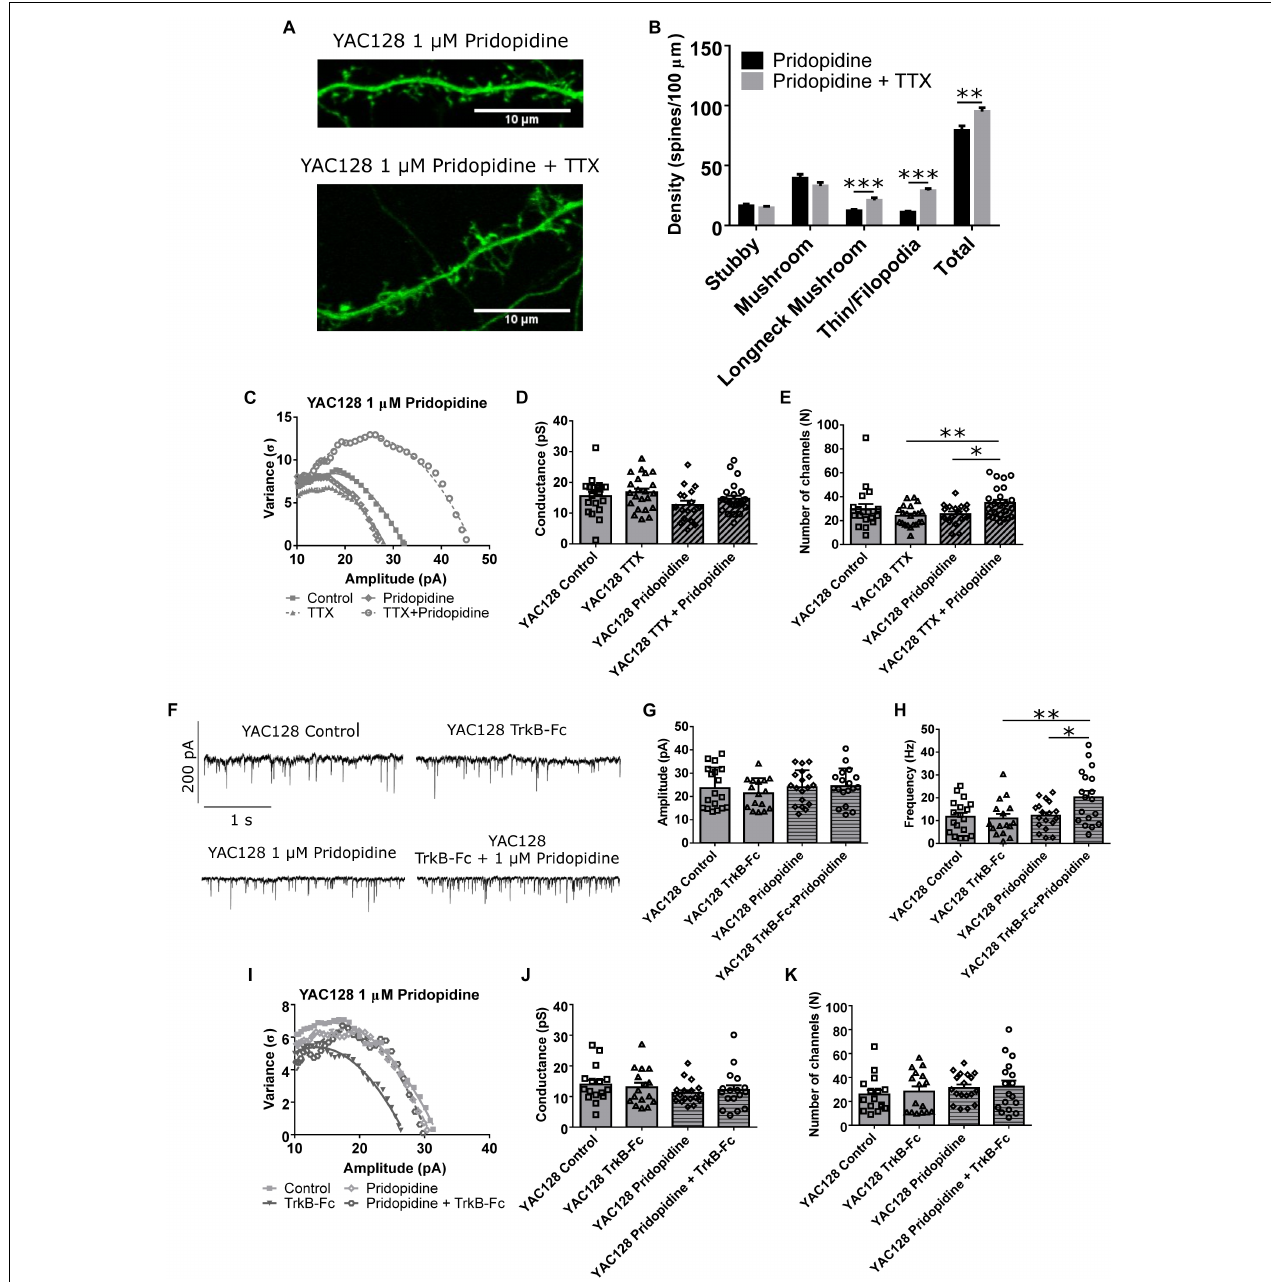
FIGURE 5 | Pridopidine restores other aspects of homeostatic plasticity. (A) Representative images of spines on CPNs filled with GFP. (B) Spine density of YAC128 CPNs treated with 1 µ M pridopidine and TTX or vehicle control. Cells treated with TTX and pridopidine had a higher density of longneck mushroom spines ( ∗∗∗ p < 0.001, unpaired t -test) and filopodia/thin spines ( ∗∗∗ p < 0.001, unpaired t -test), as well as a higher total spine density ( ∗∗ p < 0.01, unpaired t -test) than those treated with only pridopidine (cells per group n = 18, culture batches N = 3) (C) Representative current-variance plots from YAC128 CPNs treated with TTX and/or 1 µ M pridopidine. (D) Peak conductance of synapses onto YAC128 CPNs treated with TTX and/or 1 µ M pridopidine, as determined by non-stationary noise analysis. There was no significant difference between any groups (control vs. TTX: p = 0.95; pridopidine vs. pridopidine+TTX: p = 0.51; control vs. pridopidine: p = 0.25; TTX vs. pridopidine+TTX: p = 0.40, Bonferroni post hoc t -test), although there was a significant effect of pridopidine on conductance (pridopidine p < 0.05, two-way ANOVA). (E) Number of AMPARs per synapse onto YAC128 CPNs treated with TTX and/or 1 µ M pridopidine, as determined by non-stationary noise analysis. There were more AMPARs in cells treated with both TTX and pridopidine than in cells treated with only TTX ( ∗∗ p < 0.01, Bonferroni post hoc t -test) or pridopidine ( ∗ p < 0.05, Bonferroni post hoc t -test; TTX/pridopidine interaction p < 0.01, two-way ANOVA). For (D) and (E) , control n = 19, TTX n = 20, pridopidine n = 21, TTX + pridopidine n = 23, culture batch N = 4. (F) Representative traces of mEPSC recordings from YAC128 CPNs treated with TrkB-Fc and/or pridopidine. (G) mEPSC amplitude of YAC128 CPNs treated with TrkB-Fc and/or pridopidine. There was no significant difference between groups (control vs. TrkB-Fc: p =